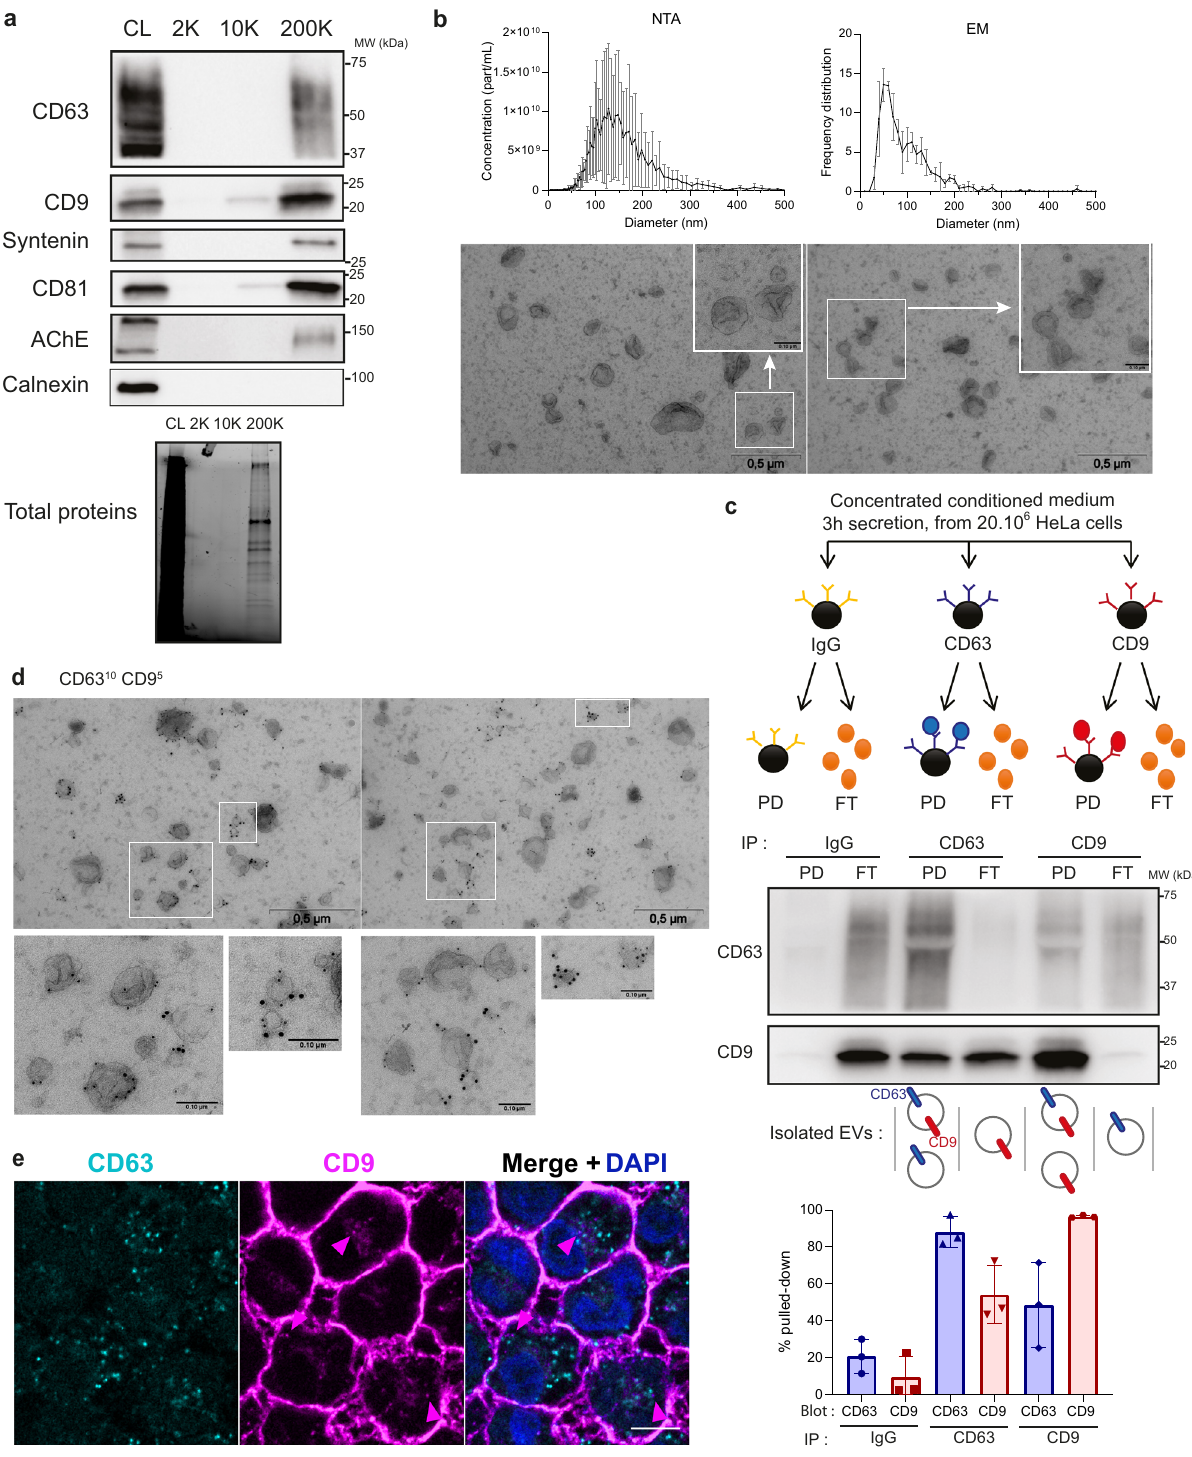
Fig. 1 CD63 and CD9 are found on two different and one common EV populations. a Western blot showing transmembrane proteins (CD9, CD63, and CD81), a cytosolic protein (syntenin-1) and two “ negative ” controls (AChE and calnexin) in cell lysates (CL) and the pellets obtained from HeLa 24h conditioned medium after differential ultracentrifugation (2K, 10K, 200K). The loaded material comes from 20×10 6 cells for the centrifugation pellets, and from 0.2×10 6 cells for the cell lysate. Representative of 3 independent experiments. b NTA and EM analysis of 200K pellets obtained from HeLa 24h conditioned medium. The quanti fi cations represent the mean of concentration or frequency of EVs of different diameters, error bars show the standard deviation (SD). N = 3 independent experiments. Scale bar of the zooms: 0.1 μ m. c Principle of immunoprecipitation of CD63 and CD9 EVs in HeLa concentrated conditioned medium and representative Western blot of the pull-down (PD) and fl ow-through (FT) of the immunoprecipitation, with quanti fi cation of the relative CD63 and CD9 bands intensity of three independent experiments (mean±SD is represented). d Immuno-EM analysis of the 200K pellet labeled with anti-CD9 (5nm gold particles) and anti-CD63 (10nm gold particles) antibodies. This experiment was performed once. Scale bar of the zooms: 0.1 μ m. e Confocal imaging of immuno fl uorescence staining of CD63 and CD9 in HeLa cells. Pink arrows show CD9 localized in intracellular compartments. Representative picture of two independent experiments. Scale bar: 5 μ